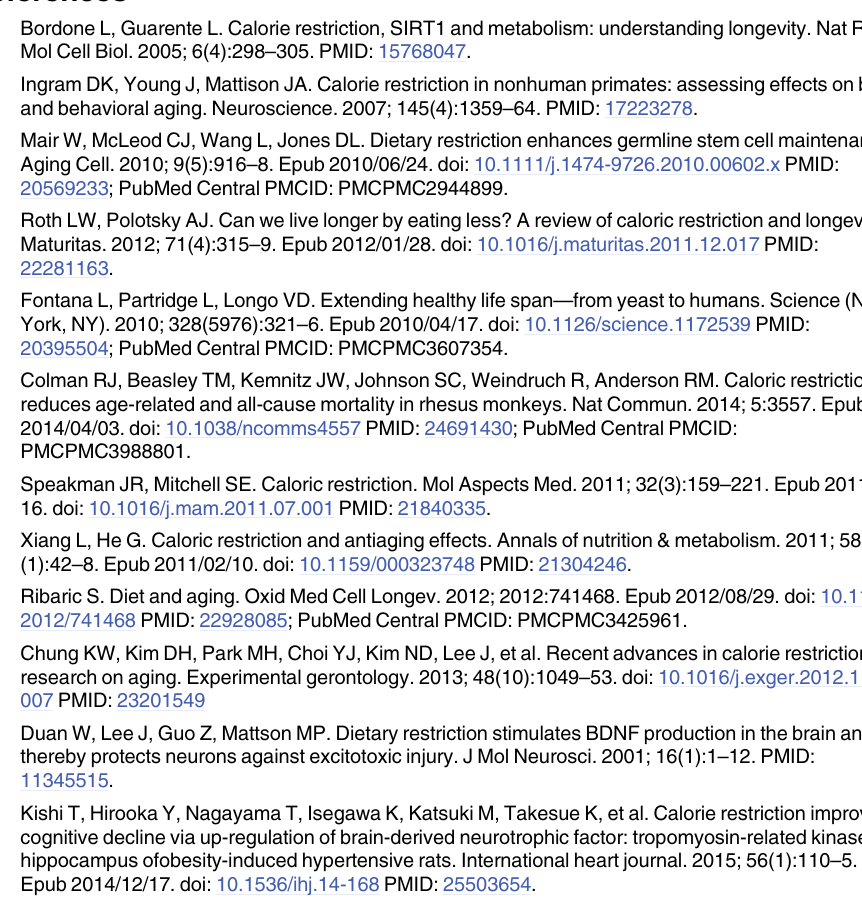
S3 Table. The mean dose of urethane (mg/kg body weight/hr) used during electrophysio- logical recording. NC1, NC2, NC3 and NC4 represent normal control cats. DR1, DR2, DR3 and DR4 represent DR